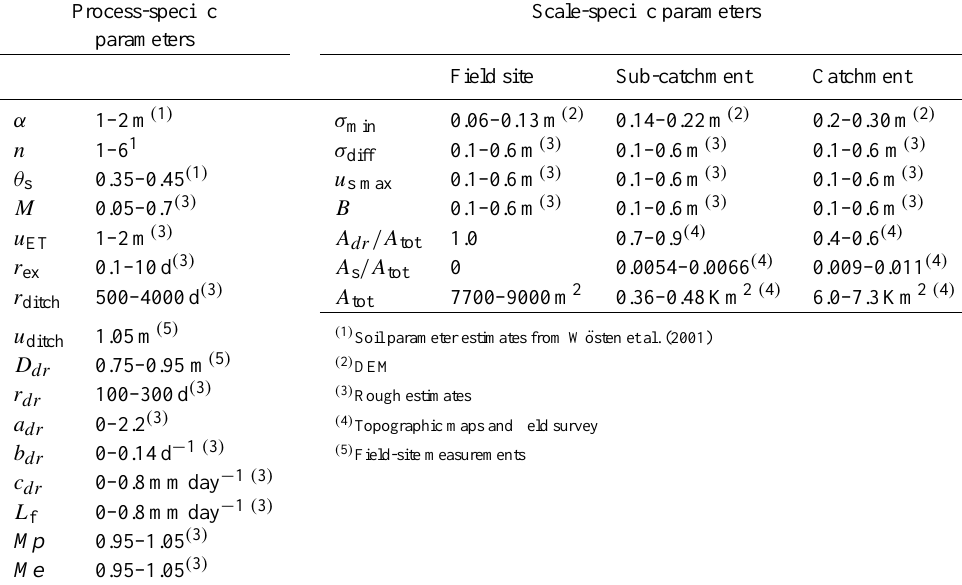
Table 2. Estimated Process-specific and Scale-specific parameter